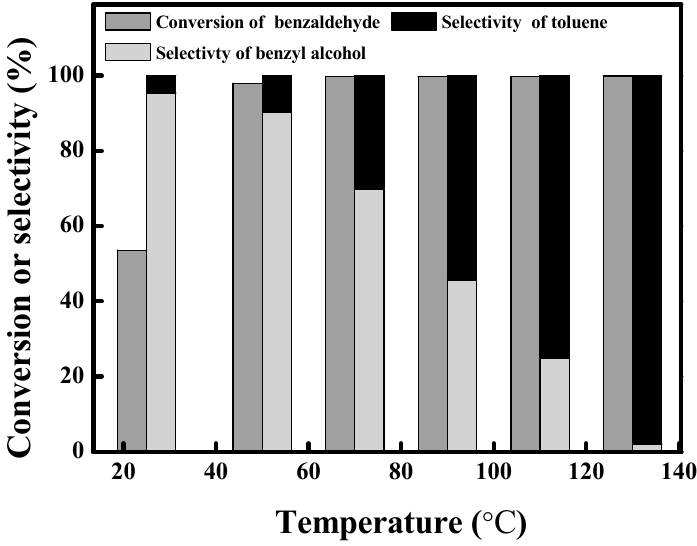
Figure 3. Results of the reduction of benzaldehyde at different temperatures. Reaction conditions: Benzaldehyde (1 mmol), 2 wt.% γ -Fe 2 O 3 @HAP-Pd catalyst (10 mg), H 2 O (10 mL), 2.5 bar H 2 , 1 h.